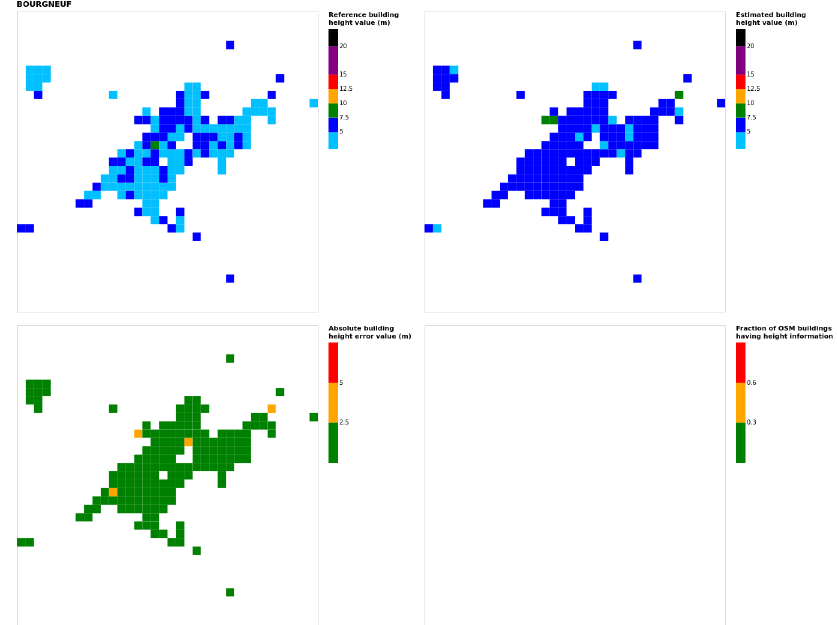
Figure B4. Results for the commune at grid cell (upper left panel) reference building height, (upper right panel) estimated building height, (lower left panel) absolute building height error, and (lower right panel) fraction of OSM buildings that have height information. For all panels except the lower right, only cells that have buildings – with at least 90% of their buildings having no height value in OSM – are